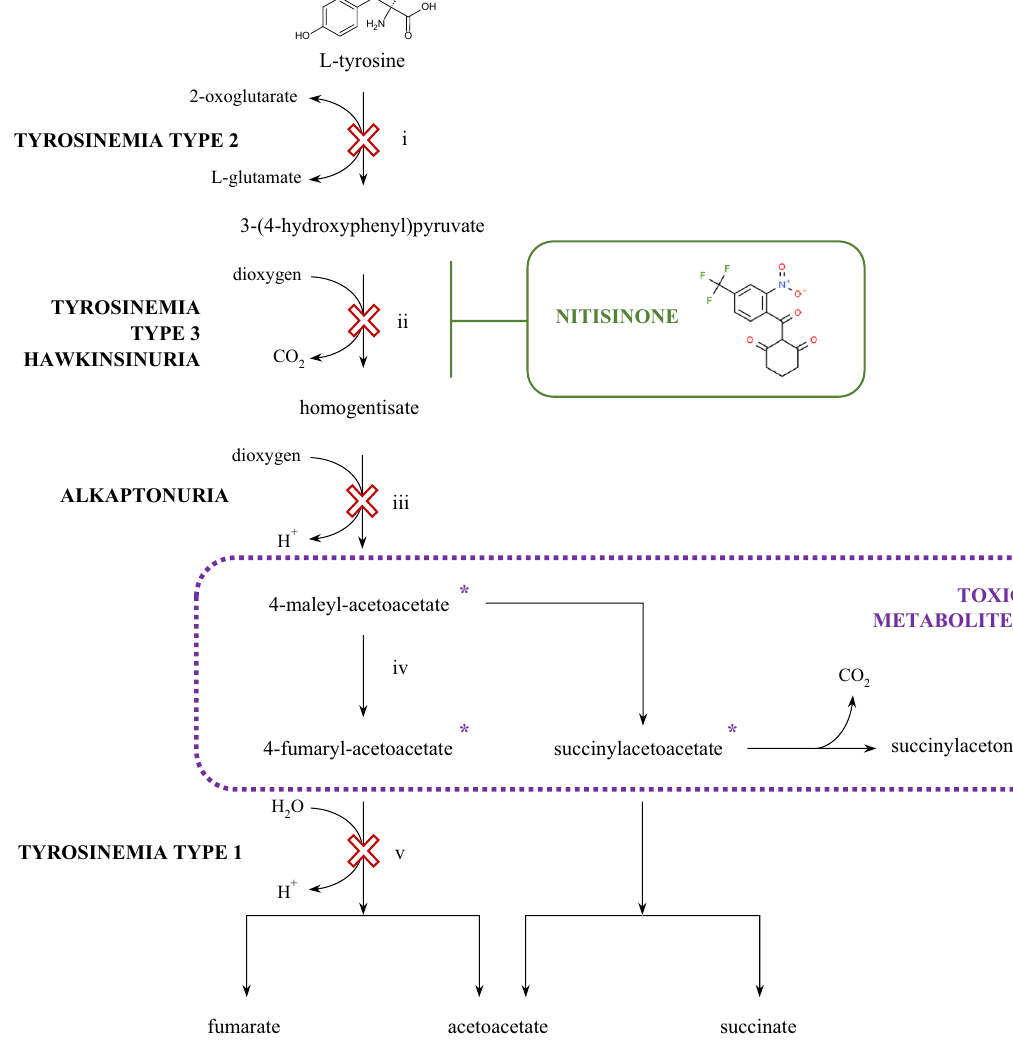
Figure 1. Tyrosine metabolic pathway highlighting the enzyme defects responsible and the site of action of nitisinone. i—tyrosine aminotransferase, ii—4-hydroxyphenylpyruvate dioxygenase,